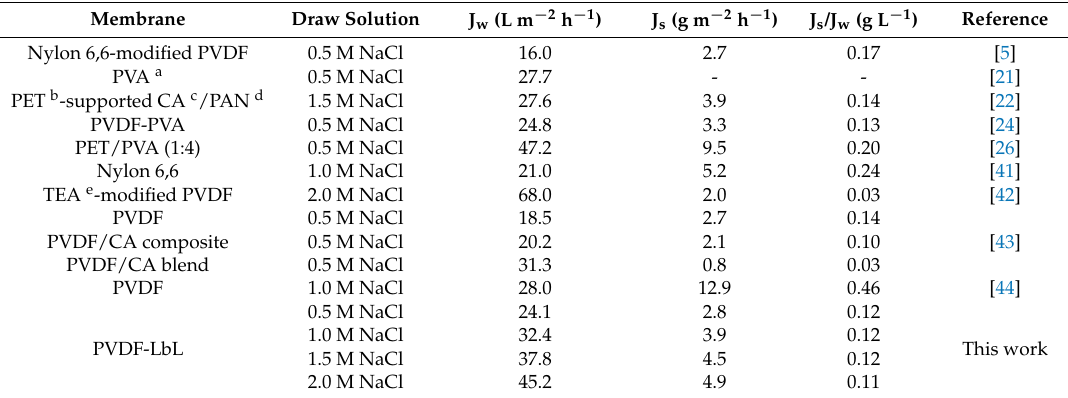
Table 3. Performance comparison of the nanofiber-supported TFC FO membranes in literature with the PVDF-LbL TFC